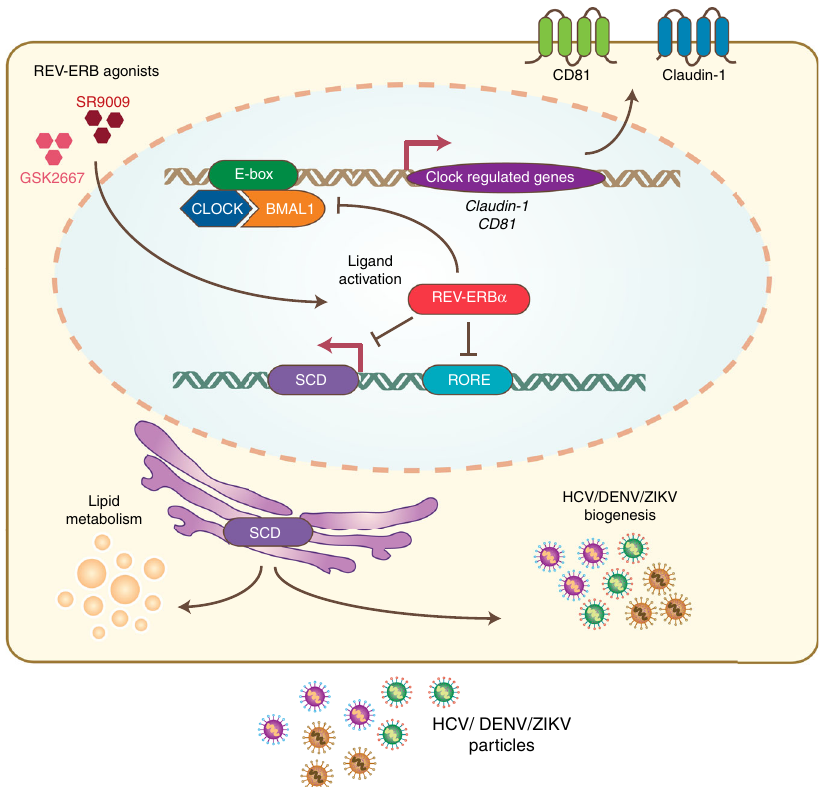
Fig. 7 Model of circadian clock components regulating HCV, DENV and ZIKV replication. The circadian activator BMAL1 regulates HCV entry into hepatocytes through modulating viral receptors CD81 and claudin-1 expression. Activating REV-ERB with synthetic agonists or protein overexpression inhibits HCV, DENV or ZIKV RNA replication via modulating SCD and subsequent release of infectious